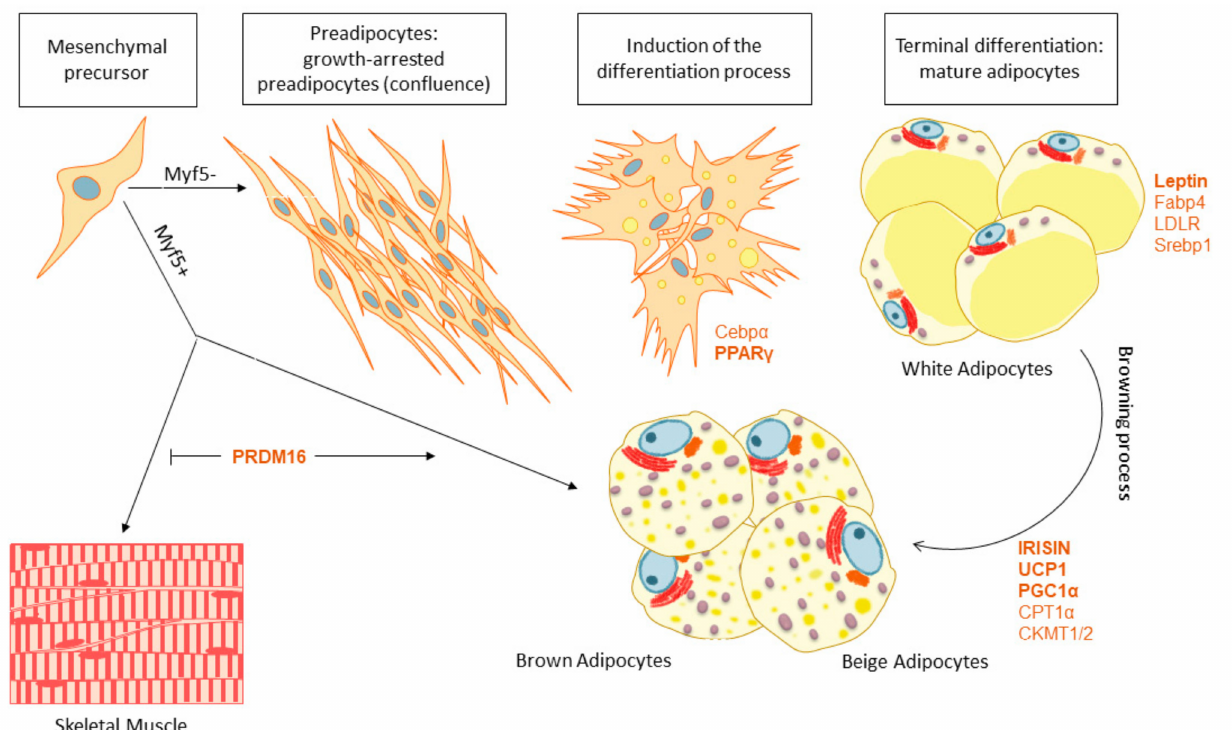
Figure 2. Adipogenesis, the differentiation process from the mesenchymal precursors to BAT or WAT and the browning process, main genes